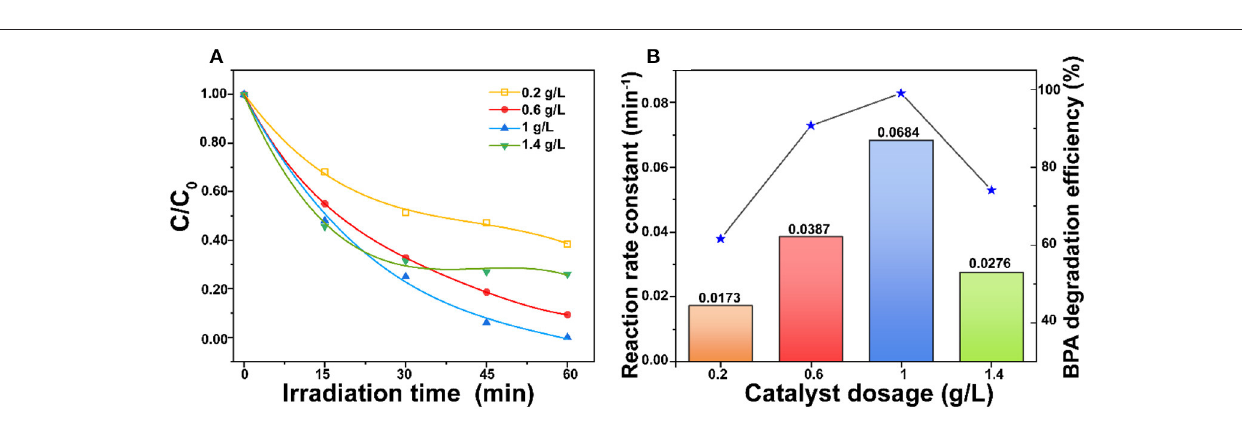
FIGURE 5 | (A) Comparison of ZnO dosages and (B) Effect of ZnO dosages on reaction rate constant for photodegradation of BPA under simulated sunlight irradiation (BPA concentration = 30 mg/L and pH =